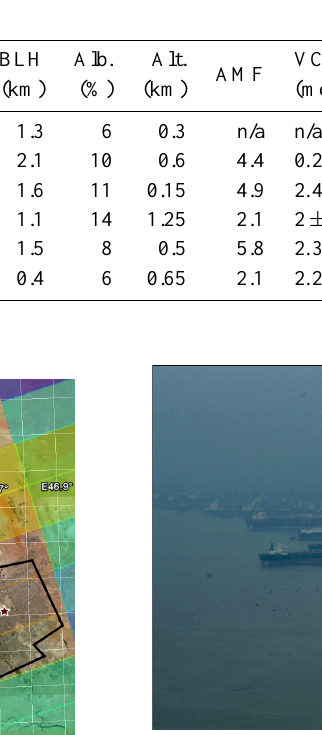
Table 3. Conditions and results of the campaign. See Fig. 3 for the places and dates of the measurements. We give the main parameters for calculating the air mass factor (AMF), i.e. the surface visibility (Vis.), the solar zenithal angles (SZA) and relative azimuth (rel Az.), the boundary layer height (BLH), the albedo (Alb.) and the altitude of the aircraft (Alt.). The tropospheric column (VCD tropo ) is the typical value found while overflying the areas.